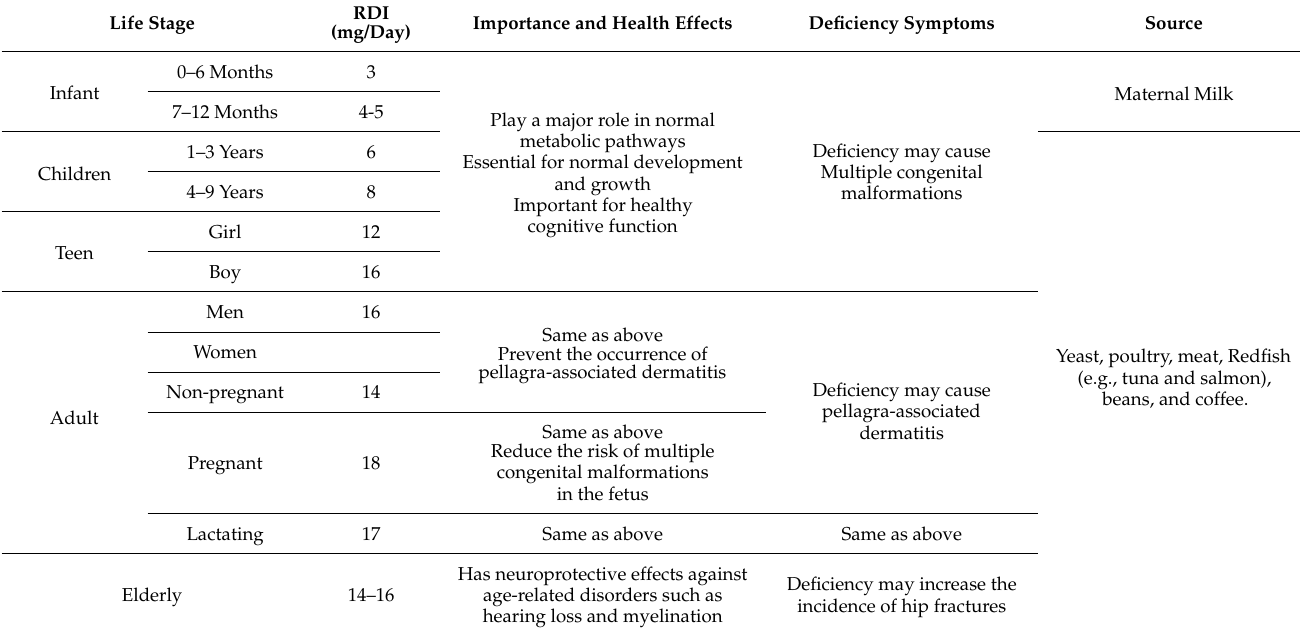
Table 3. Recommended daily intake (RDI), main actions, and natural sources of vitamin B3 (niacin) in different life